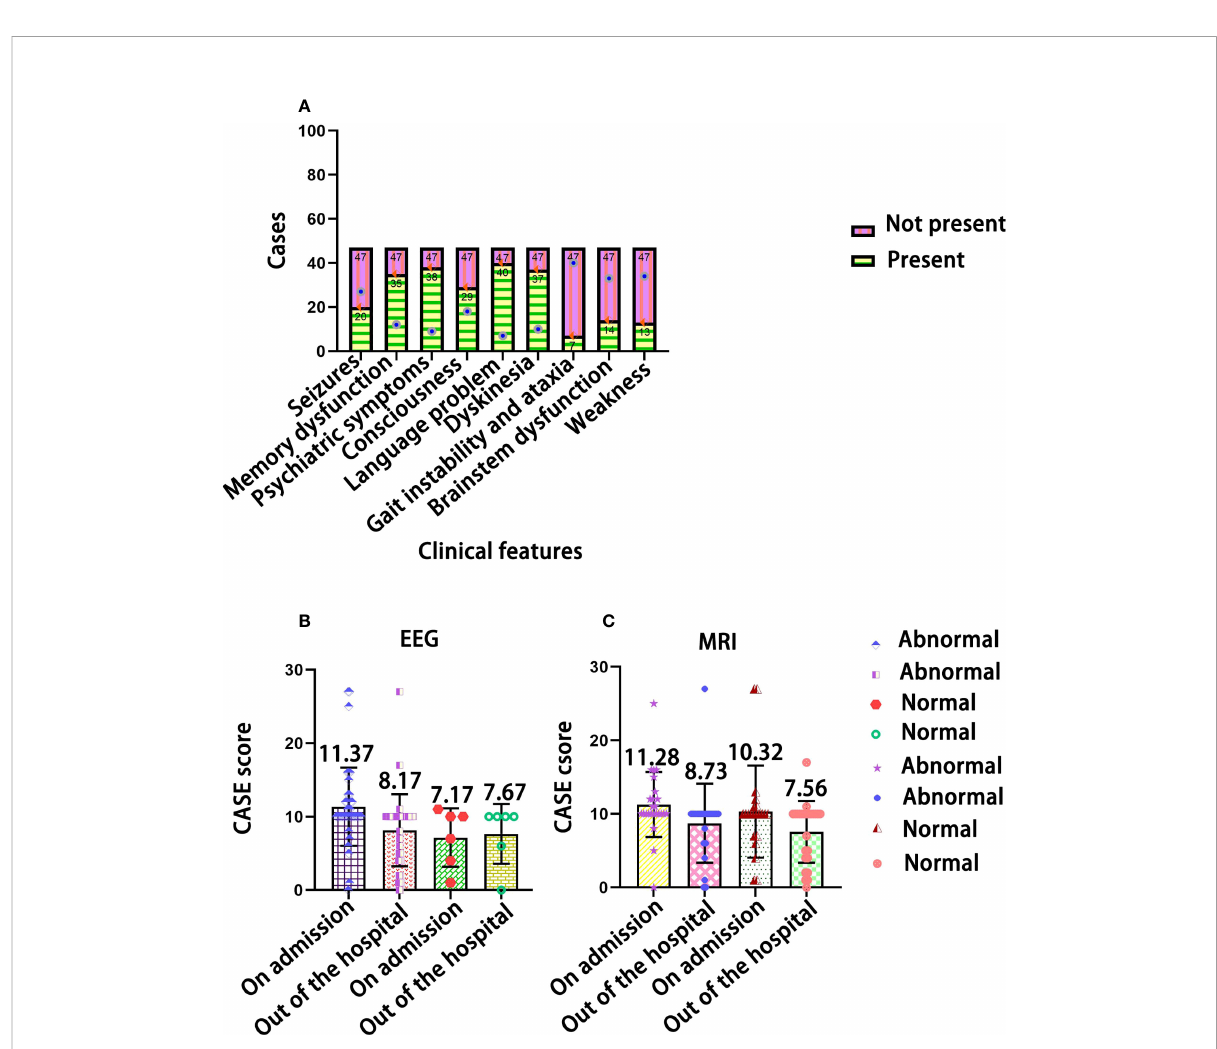
FIGURE 3 The distribution of clinical features in children with AE. (A) The relationship of CASE total scores with EEG (B) and MRI test results (C)